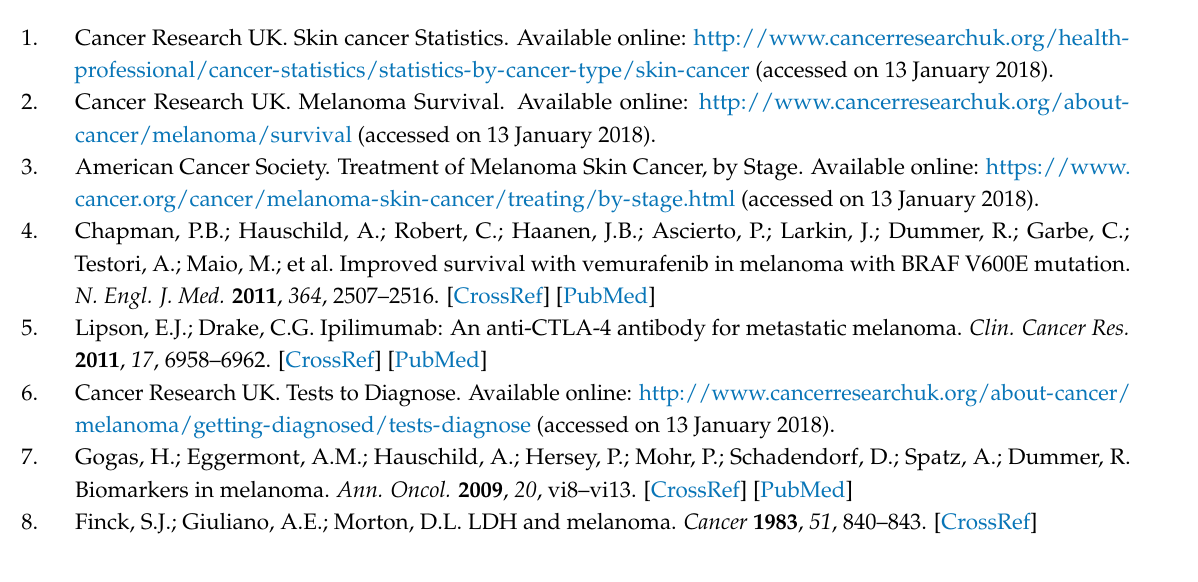
Supplemental Methods, Supplemental Table S1: Potential diagnostic circulating miRNA biomarkers for melanoma, Supplemental Table S2: Potential prognostic circulating miRNA biomarkers for melanoma, Supplemental Table S3: List of miRNAs included in miRNA biomarker